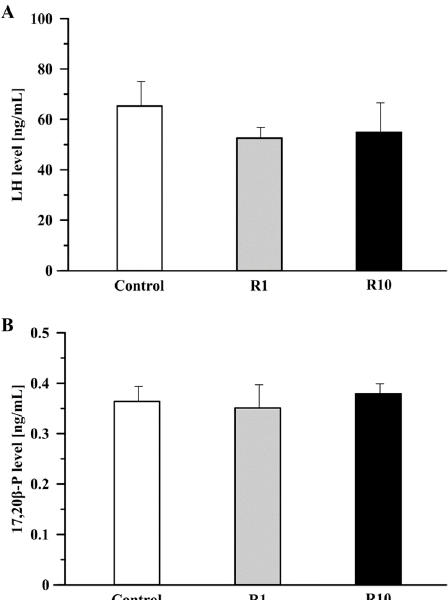
Figure 1. The effect of Roundup at a concentration of 1 (R1) and 10 ng/mL (R10) on LH ( A ) and 17,20 β -progesterone (17,20 β -P) ( B ) secretion from crucian carp ( Carassius carassius ) pituitary ( A ) and ovarian follicles ( B ) in vitro. Data are expressed as means ± SEM ( n = 3 wells/each group, 2 pituitaries/well, n = 5 wells/each group, ~150 ovarian